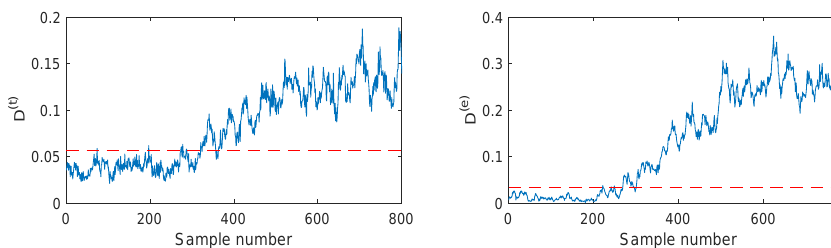
Figure 14. CAE-SVDD monitoring charts for fault F5.